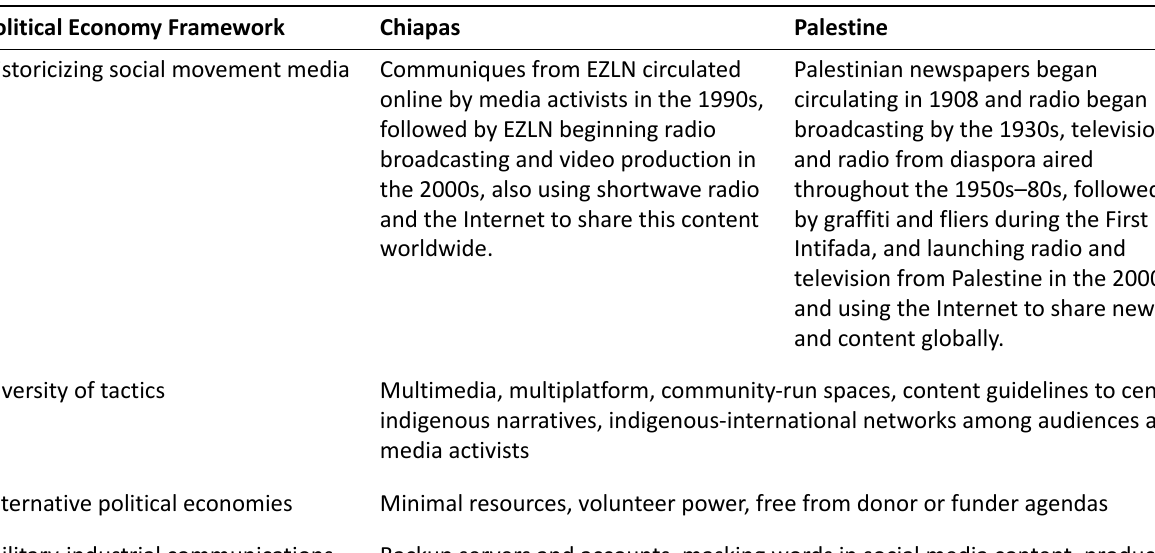
Table 1. Strategies of social movement media from Chiapas to